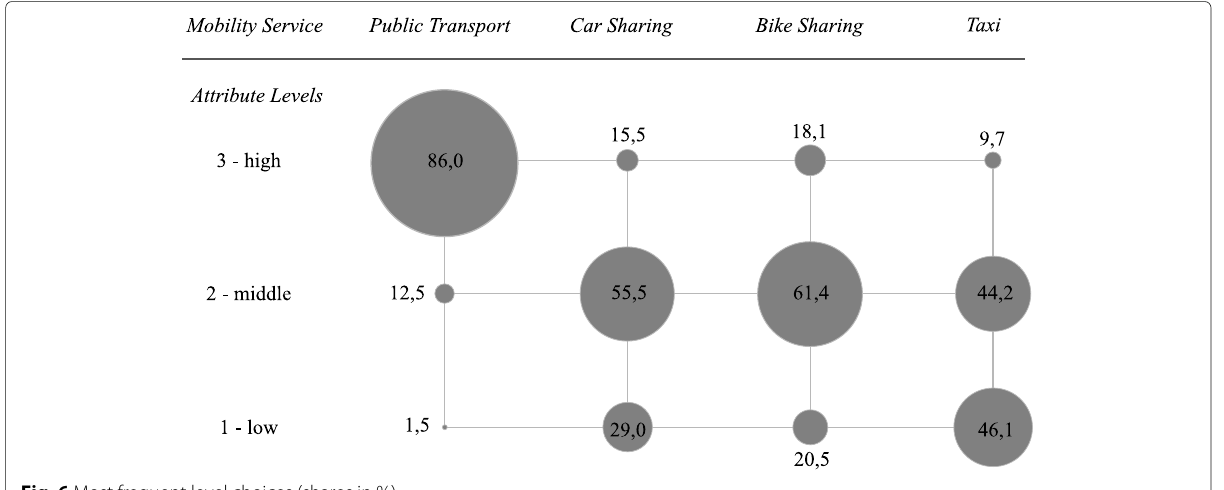
Fig. 6 Most frequent level choices (shares in %)